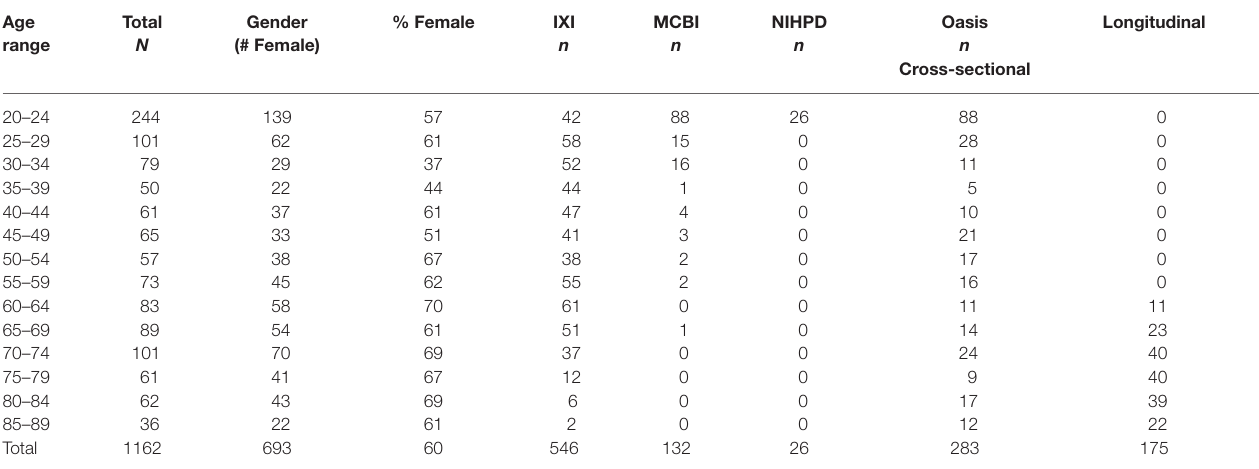
TABLE 1 | Demographic information by five-year age group broken down by gender and image source . Age Total Gender % Female IXI MCBI Oasis Longitudinal